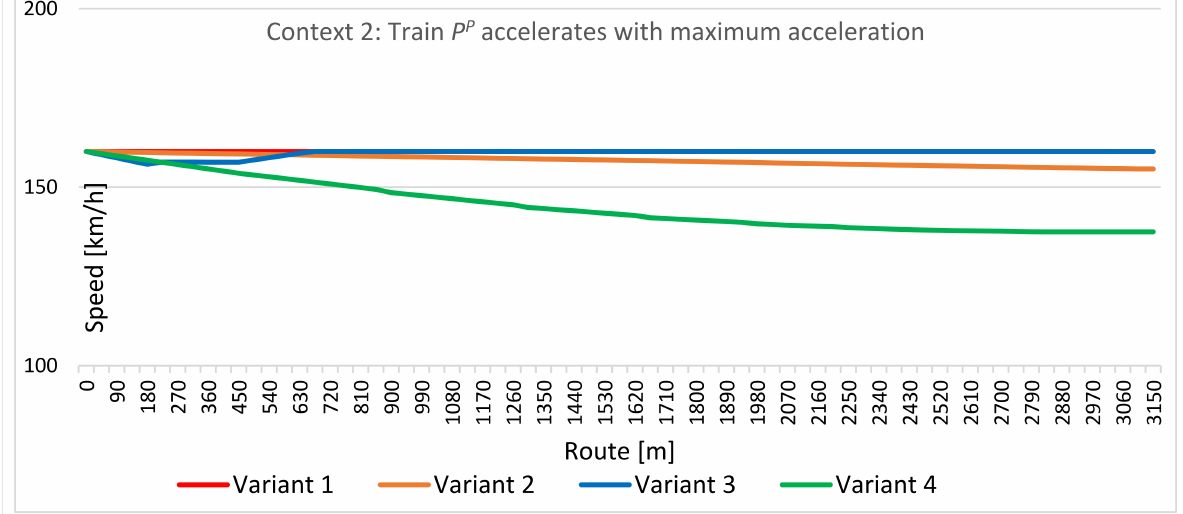
Figure 11. Speed profiles of train P N for different movement variants; context 2 (source: own